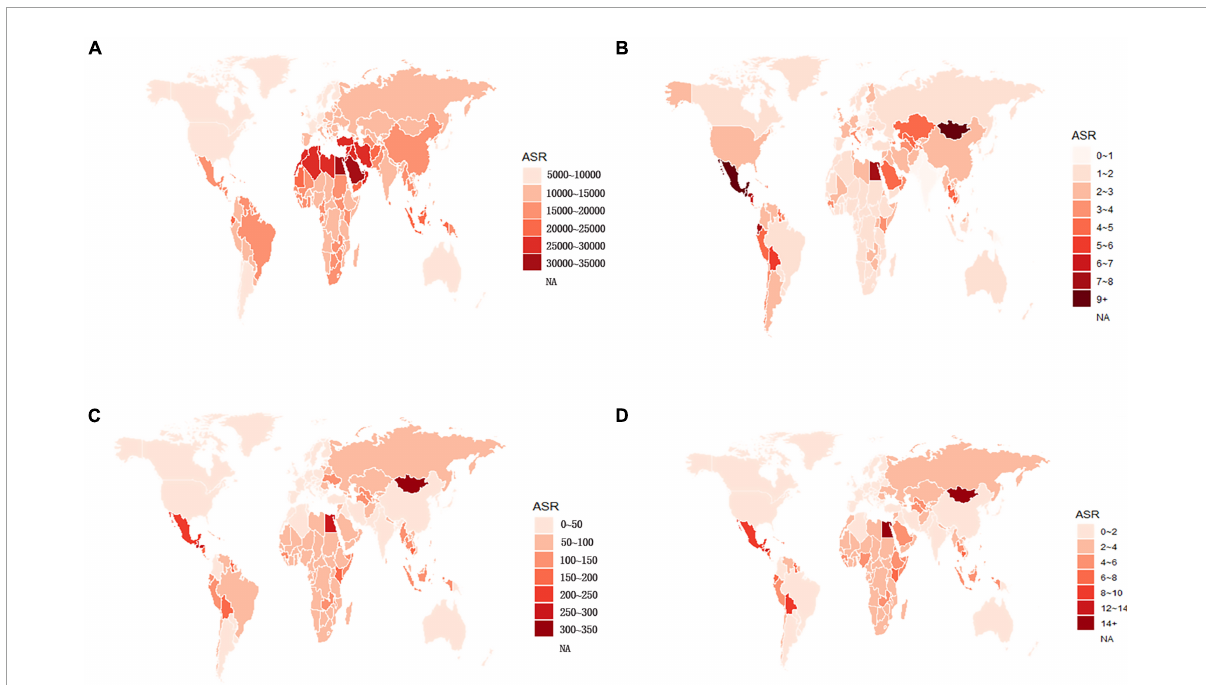
FIGURE1 Global age-standardized (A) prevalence, (B) incidence, (C) DALY, and (D) death rates of NAFLD in 2019. NAFLD, non-alcoholic fatty liver disease; DALY, disability-adjusted life